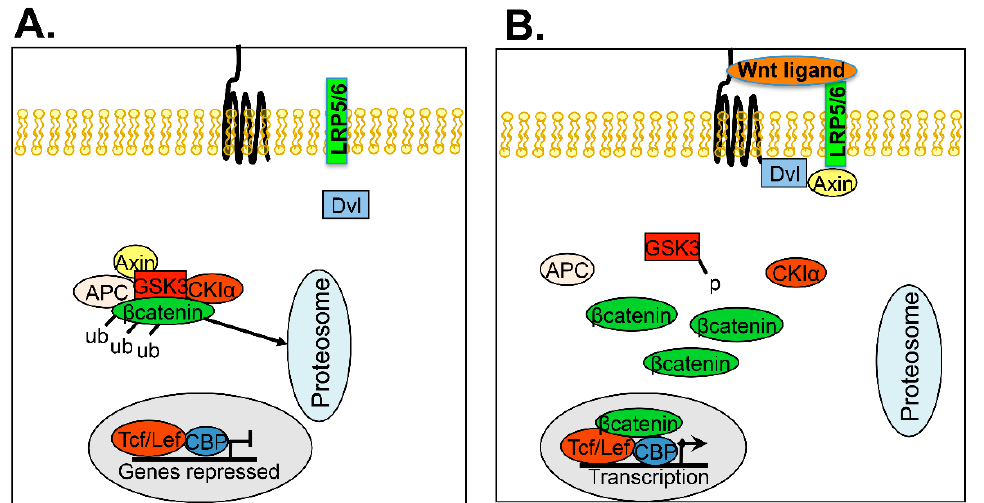
Figure 6. Wnt Signaling Cascade. ( A ) Basal state without the presence of Wnt ligand activation. β -catenin is ubiquitinated and sent to the proteosome for destruction. ( B ) Activation of the Wnt pathway via binding of a Wnt ligand to the Frizzled receptor and LRP5/6 resulting in recruitment of Disheveled (Dvl) and axin to the cell membrane. β -catenin is released from the destruction complex and translocates to the nucleus to act as a co-transcription factor.